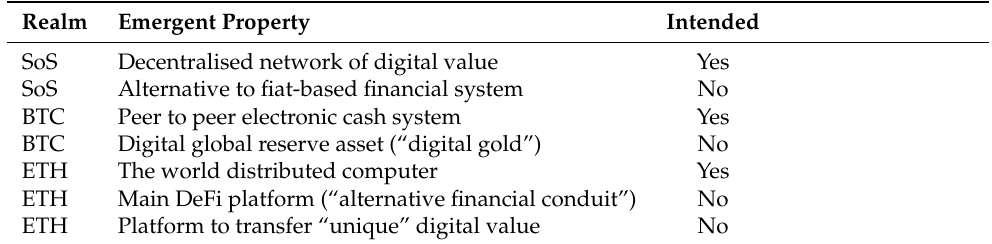
Table 7. Intended and unintended emergent